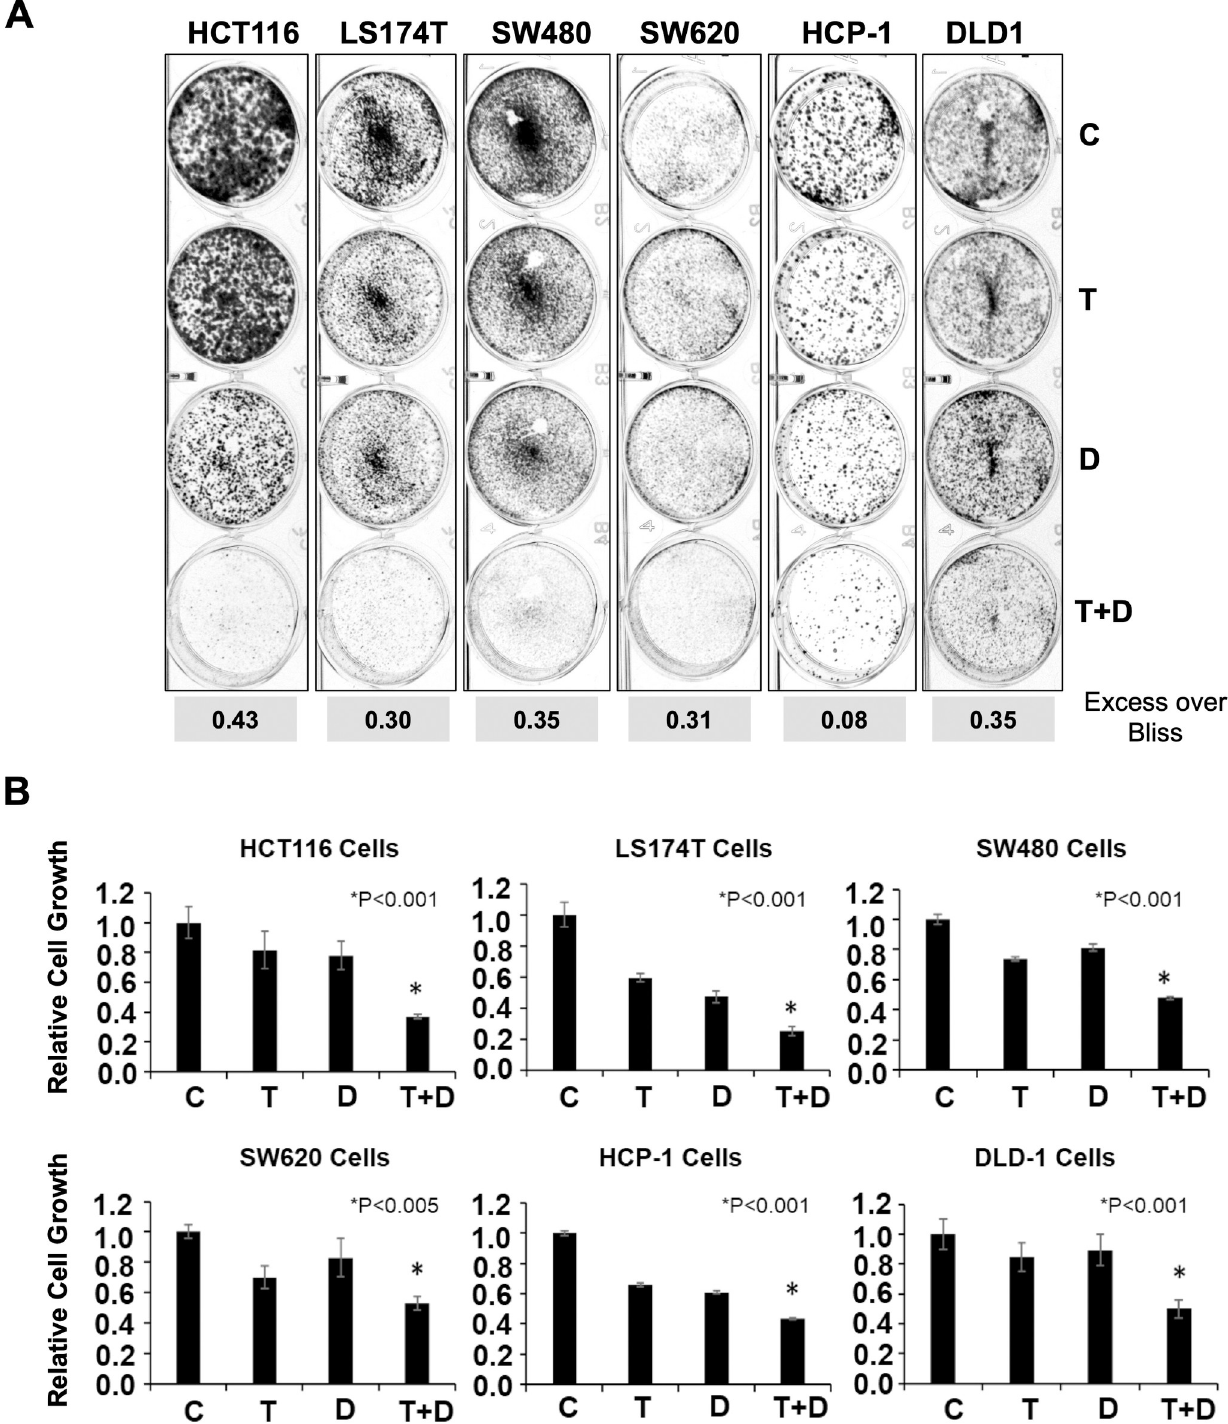
Fig 2. The combination of SRC and MEK inhibition is synergistic in multiple KRAS-mutated CRC cell lines. A , the results of colony formation assays performed to demonstrate the synergy of trametinib and dasatinib in multiple KRAS-mutated CRC cell lines. Representative images of different cell lines are shown. The numbers in the boxes below the images indicate synergy (excess over Bliss). C, control; T, trametinib; D, dasatinib; T+D, trametinib and dasatinib. B , the results of MTT assays performed using different KRAS-mutated CRC cell lines to further validate the enhanced efficacy of combining trametinib with dasatinib as compared with either drug alone or DMSO (control). All cells were treated for 72 hours. The data were normalized to control (taken as 1.0) and relative cell growth were plotted. All data are presented as mean ( ± SD) values. P values shown are for combination treatments when